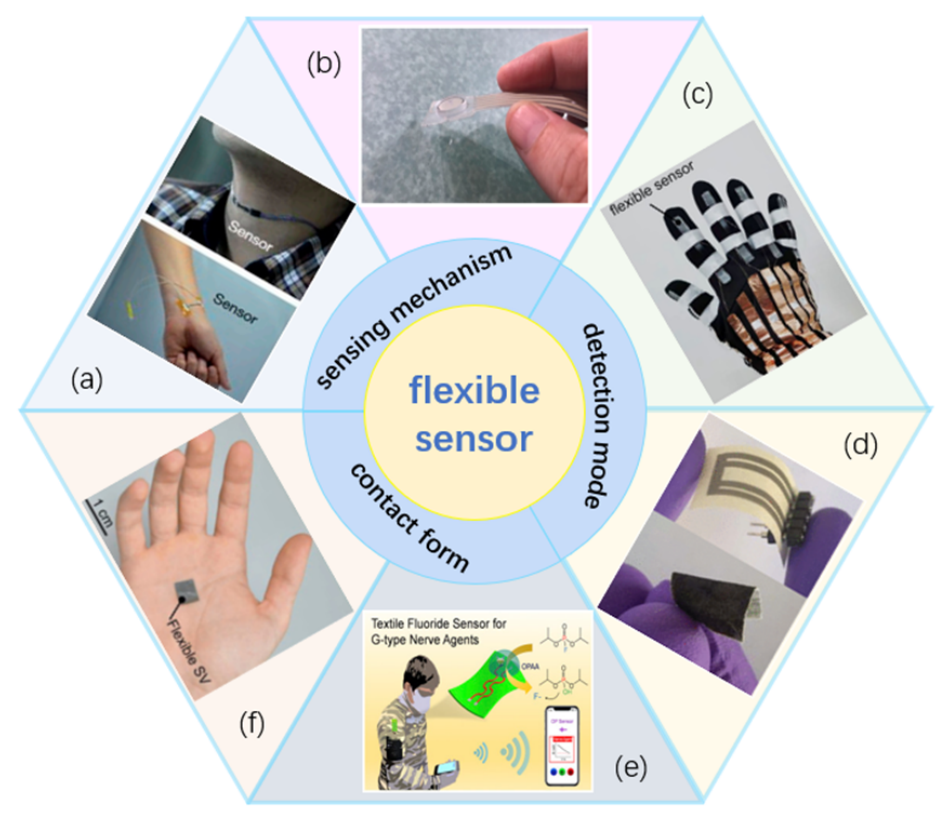
Figure 2. Flexible sensors based on different sensing mechanisms, detected objects, and contact forms: ( a ) a resistive strain sensor attached to the skin [31]; ( b ) a wearable triboelectric sensor for a dynamic prosthetic fit [32]; ( c ) a highly stretchable, tough, and sensitive strain sensor [33]; ( d ) organic chemical sensors for the detection of chemically corrosive vapors [34]; ( e ) contact sensors for bio-detection of flexographically printed fabrics made of fluorine-containing G-type nerve agents [35]; and ( f ) a non-contact sensor for a physiological monitoring system based on the wearer’s palm